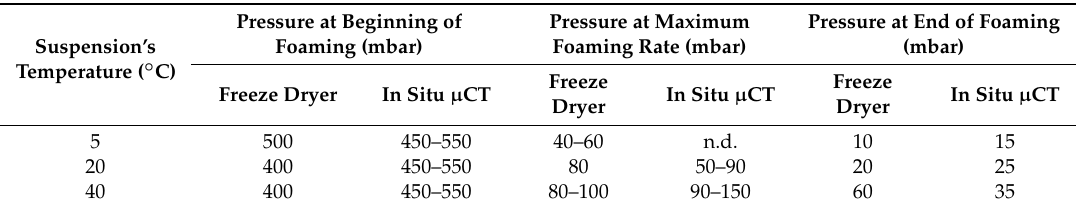
Table 1. Comparison of the pressures of beginning, end, and maximum of foaming at temperatures of 5, 23, and 40 ◦ C by in situ µ CTs (ILK) and by freeze dryer (IKTS) [24]. Suspension’s Temperature ( ◦